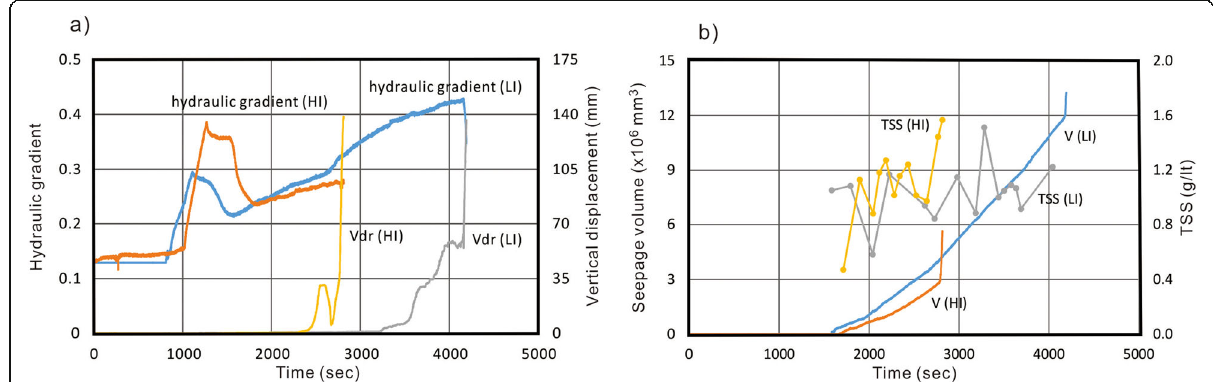
Fig. 4 Time series data of hydraulic gradient, vertical displacement, seepage volume and TSS for the sample S568 at a low inflow rate (LI) of 1.1 × 10 − 5 m 3 /s and high inflow rate (HI) 1.67 × 10 − 5 m 3 /s. a Hydraulic gradient and vertical displacement; b Seepage volume and